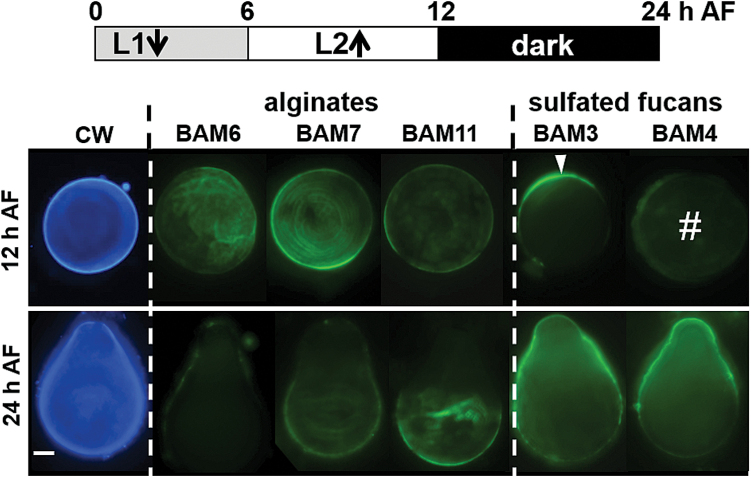
Effect of a reorientation of the growth axis on the deposition of cell wall polysaccharides in developing F. serratus zygotes. Zygotes were cultivated and exposed to unidirectional light (L1) while an initial growth axis was established. At 6 h after fertilization (AF), the zygotes were reoriented 180 ° from the initial light source (L2), until the time of observation. Blue fluorescence shows Calcofluor White stain. The green fluorescence shows the detection of the BAM6, BAM7, and BAM11 alginate epitopes, and also the BAM3 and BAM4 fucan epitopes. Scale bar=50 µm.